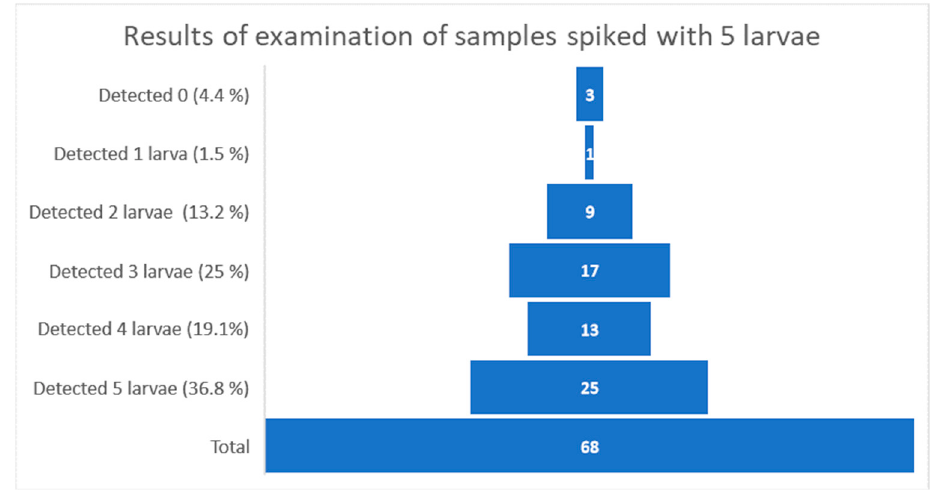
Figure 3. Graphical interpretation of the distribution of samples results spiked with five larvae (number of laboratories in bricks).